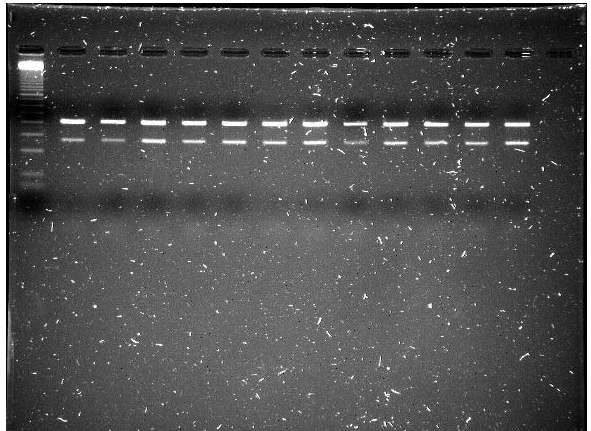
Figure 3 - Semi-quantitative RT-PCR for the GH gene. First lane - 100 bp ladder of molecular weight markers. The 12 lanes represent co-amplified samples of GH cDNA (418 bp) and the β -actin cDNA (264 bp). Lanes 1-6 show the AB genotype; lanes 7-12 show the AA genotype. The samples were run on 2% agarose gels.